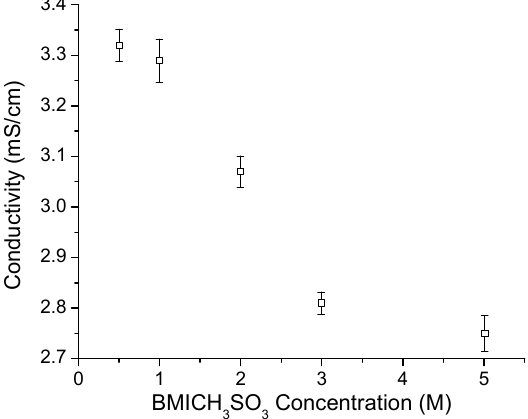
Figure 2. Conductivity of BMICH 3 SO 3 solutions in IL BMIBF 4 .